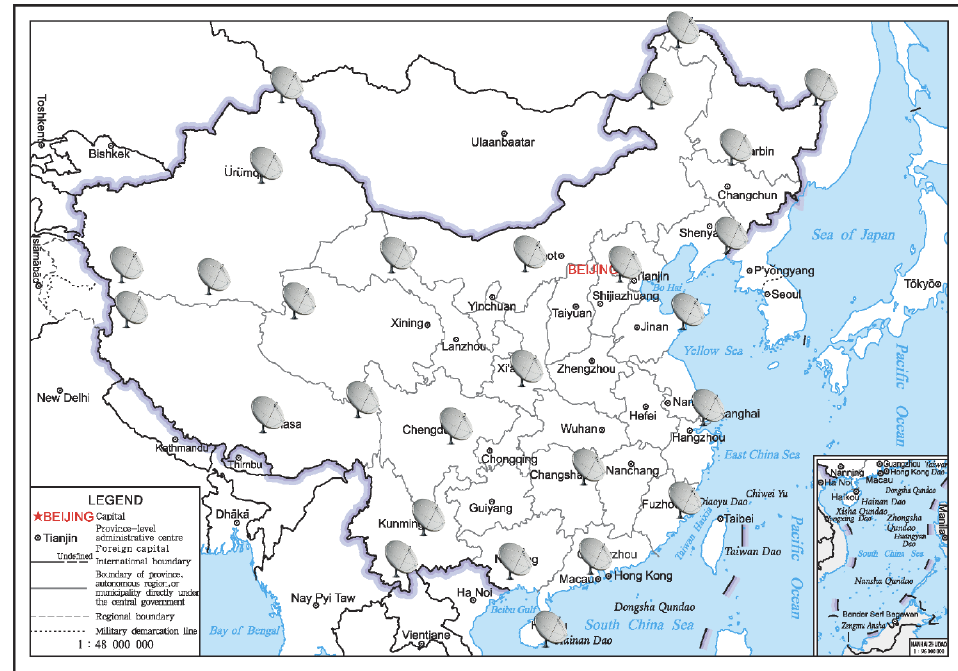
Figure 2. The 27 MSs located in mainland China.